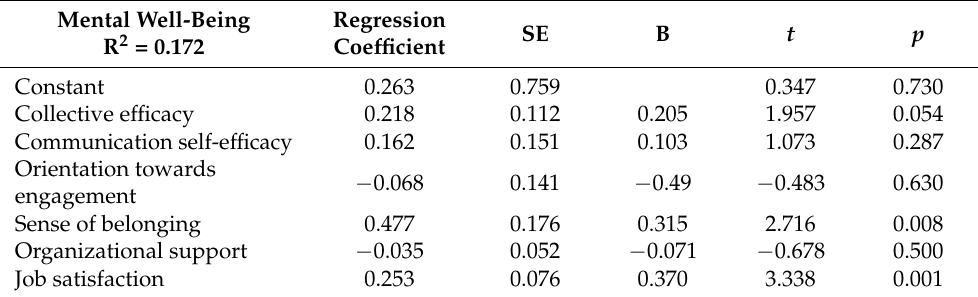
Orientation towards